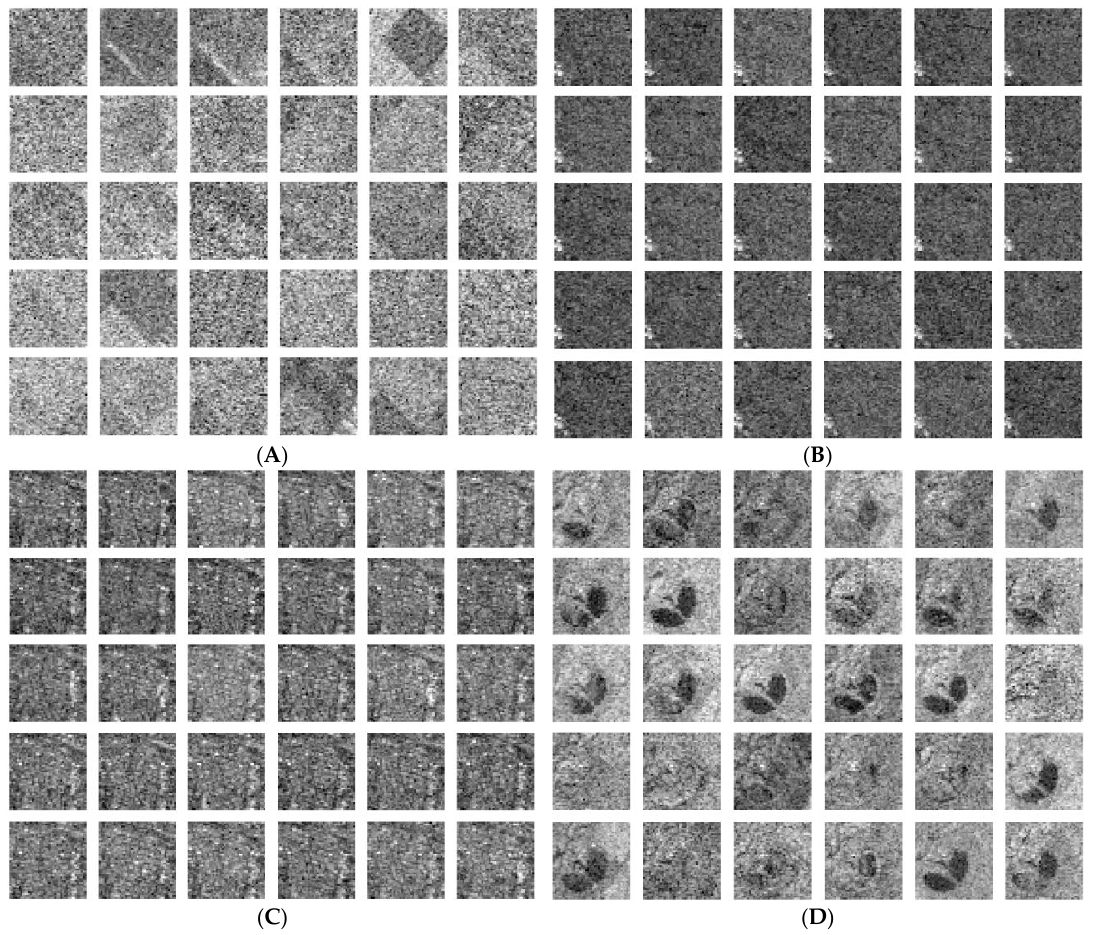
Figure 8. Categories of evolutions that we can e xtract from the Buzău scene: ( A ) agricultural evolution, ( B ) forest evolution, ( C ) urban evolution, and ( D ) water evolution.